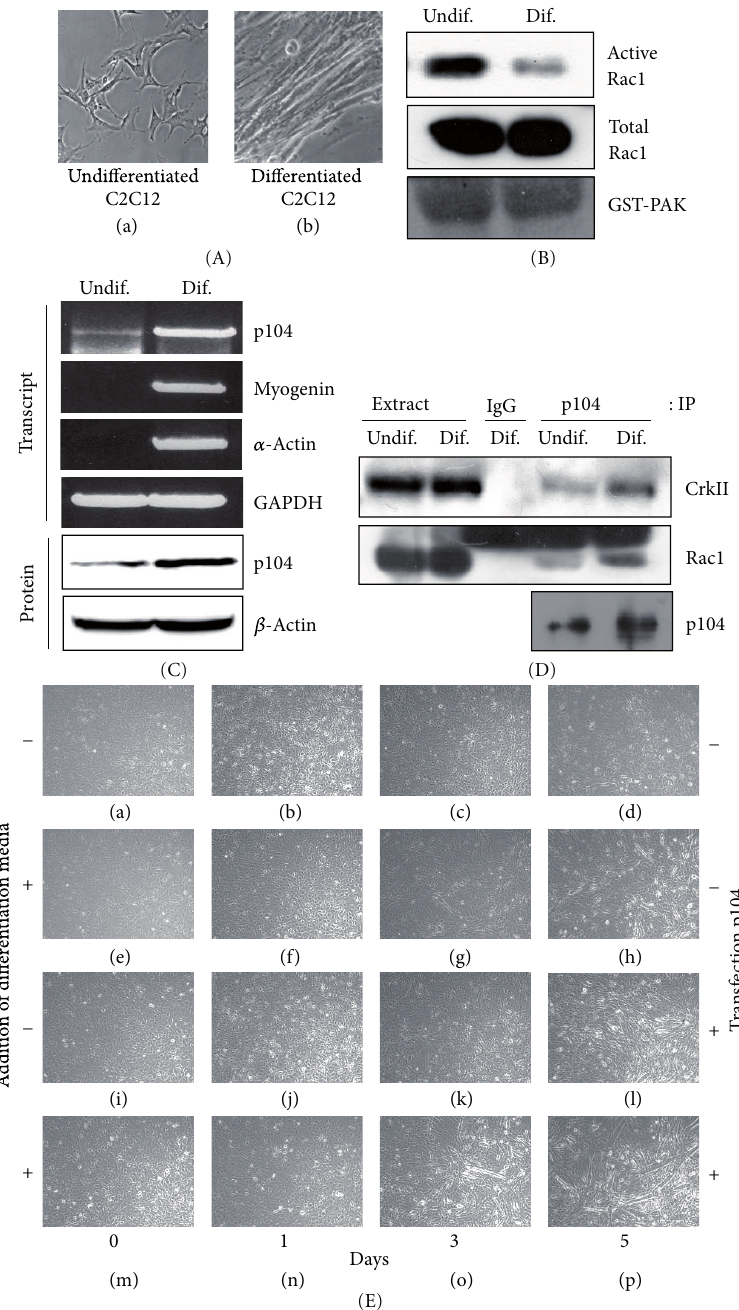
Figure 5: Interaction of p104 with Rac1 and CrkII during C2C12 differentiation. (A) C2C12 cells were grown to confluence (a) and then placed in differentiation medium for 5 days to induce the differentiation into myotube formation (b). (B) The activity of Rac1 was decreased during C2C12 differentiation. The amount of GTP-bound Rac1 in cell lysates prepared from undifferentiated (Undif.) or differentiated (Dif.) myoblasts was analyzed by GST-PAK pull-down analysis. Rac1-GTP (active form) and total Rac1 from the same extracts were detected by Western blotting with Rac1 antibody. (C) Transcript levels of p104, myogenin, and 𝛼 -actin and the protein level of p104 were determined in the absence (Undif.) or presence (Dif.) of differentiation medium by reverse transcription-polymerase chain reaction and Western blot analysis, respectively. The mRNA levels of p104 and differentiation markers were increased 5 days after the induction of differentiation. Levels of glyceraldehydes-3-phosphate dehydrogenase (GAPDH) transcript and actin were used as a control. (D) Interaction of p104 with Rac1 and CrkII was increased during the C2C12 differentiation. C2C12 cells were grown in differentiation media for 5 days and total protein was extracted. Lysates from undifferentiated or differentiated cells were immunoprecipitated with p104 antiserum, and then Western blot analysis was performed using anti-CrkII, anti-Rac1, and anti-p104 antibodies. (E) The effect of p104 overexpression in the myotube differentiation. The C2C12 cells were transfected with p104 ((i)–(p)) and grown in the presence ((e)–(h), (m)–(p)) or absence ((a)–(d), (i)–(l)) of differentiation media. The photos were taken at the indicated days after the addition of differentiation